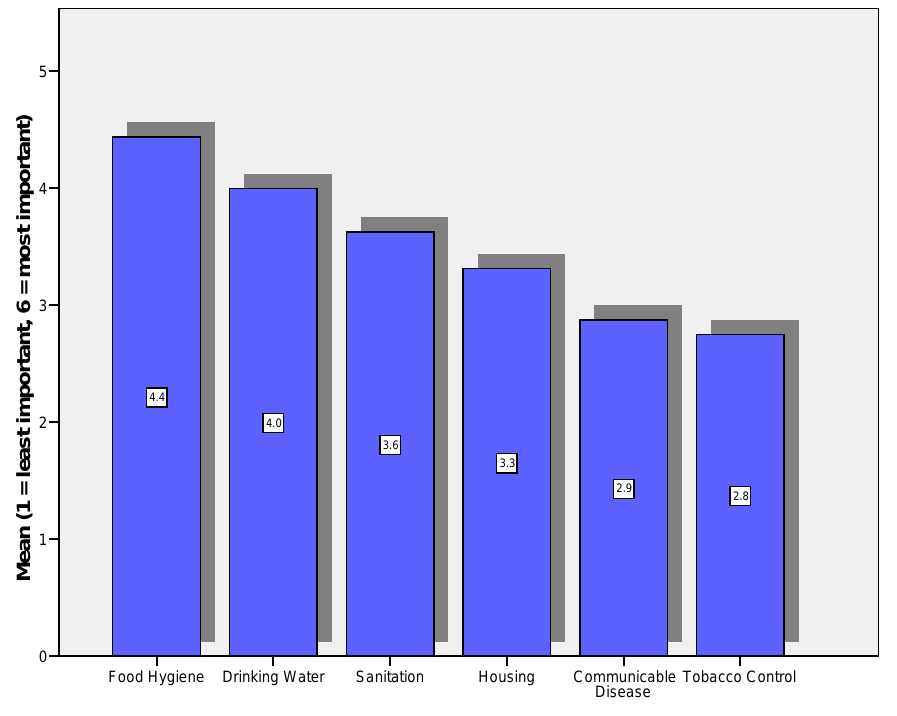
Figure 1. Mean Priority Score for Environmental Health